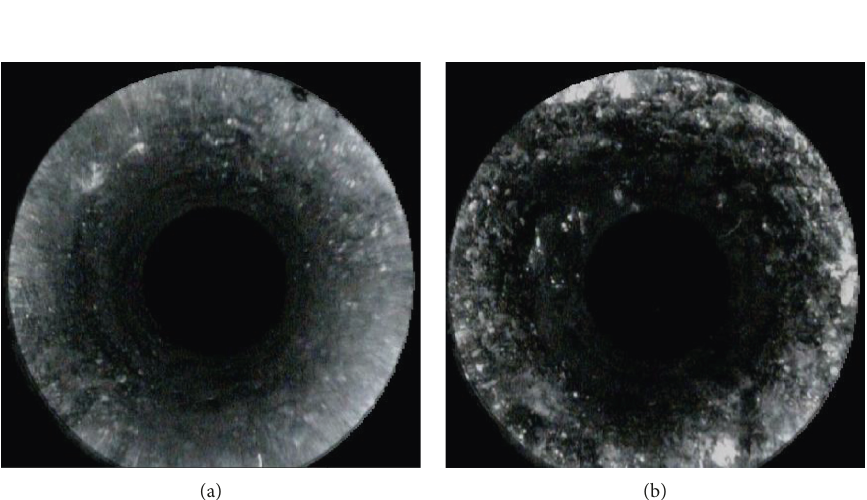
Figure 11: Effect diagram of 5# borehole before and after blasting: (a) before blasting, (b) after